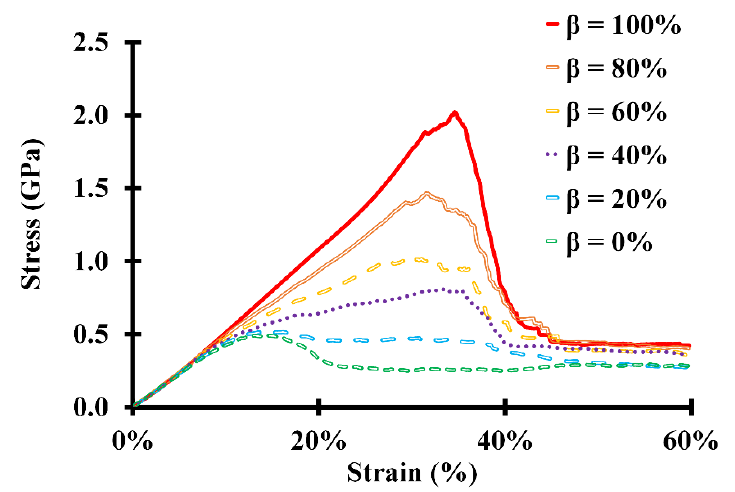
Figure 4. Strain –stress curve of the collagen fibril as a function of the amount of crosslink (β) pre- Figure 4. Strain–stress curve of the collagen fibril as a function of the amount of crosslink ( β ) dicted using the coarse-grained model under axial tensile testing. predicted using the coarse-grained model under axial tensile